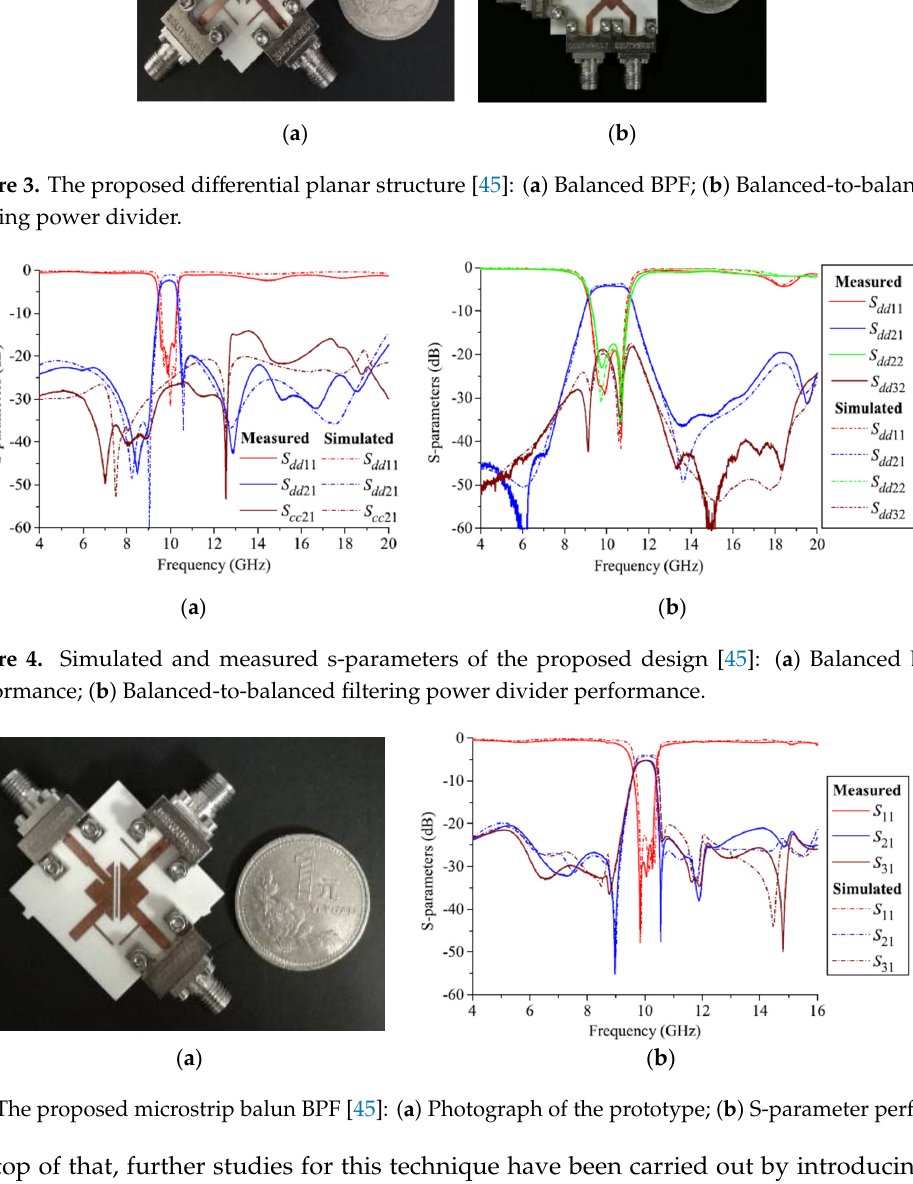
Figure 3. The proposed differential planar structure [45]: ( a ) Balanced BPF; ( b ) Balanced-to-balanced filtering power divider.